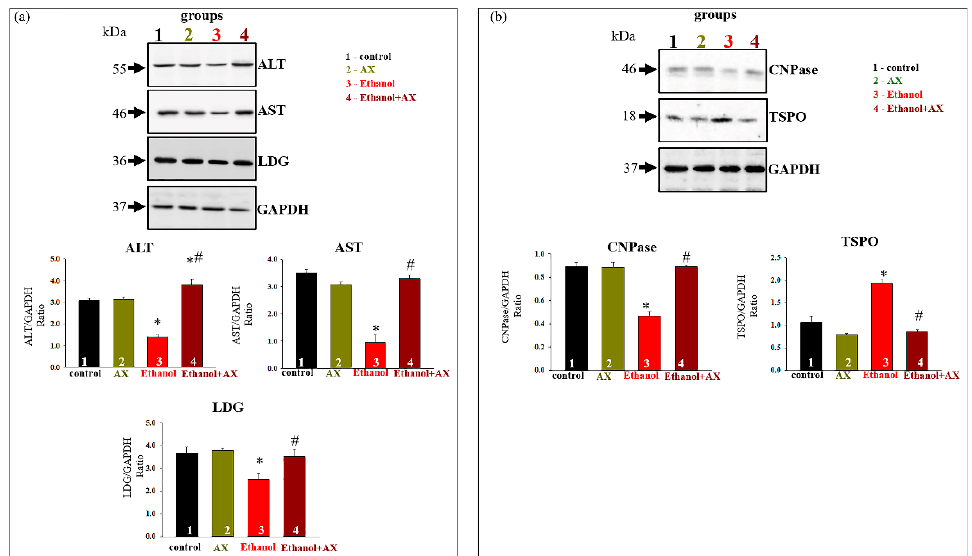
Figure 2. The effect of AX and Ethanol on the content of ALT, AST, LDG, CNPase, and TSPO in rat liver tissue. ( a )—upper part: immunostaining with ALT, AST, and LDG antibodies; low past: quantification of immunostaining by computer-assisted densitometry presents as a ratio of proteins to GAPDH. GAPDH was used for normalization of proteins. ( b )—upper part: immunostaining with CNPase and TSPO antibodies; low part: quantification of immunostaining by computer-assisted densitometry presented as a ratio of proteins to GAPDH. The data are presented as the means ± SD of three independent experiments. * p < 0.05 significant difference in the protein levels in comparison with the control (group 1). # p < 0.05 compared to RLM isolated from ethanol-administrated rats (group 3). The statistical significance of the differences between the pairs of mean values was evaluated using the Student–Newman–Keul test, while ethanol treatment (group 3, red columns on all diagrams) significantly reduced the protein content. Thus, we showed a decrease in ALT levels by 60%, AST by 70%, and LDG by 40% compared with the control group (red columns 3 vs. black columns 1). At the same time, in the liver of rats treated with both ethanol and AX (group 4, scarlet columns in all diagrams), the indicators increased approximately to the control values (scarlet columns 4 compared to black 1). Thus, AX is able to abolish ethanol-induced changes in the liver tissue lysates.